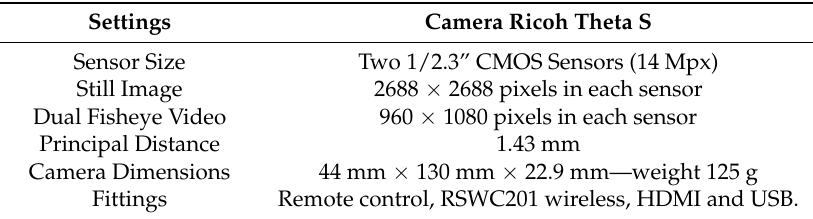
Table 1. Ricoh Theta S digital camera and fisheye lens